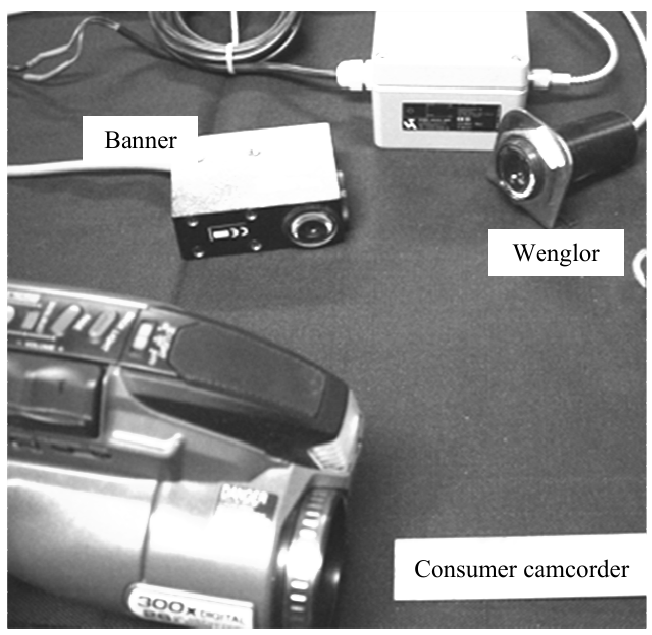
Figure 1. Sensors for determination of wood loading resulting from abrasive machining (clockwise from lower left: consumer camcorder, Banner® contrast detector and Wenglor® intensity